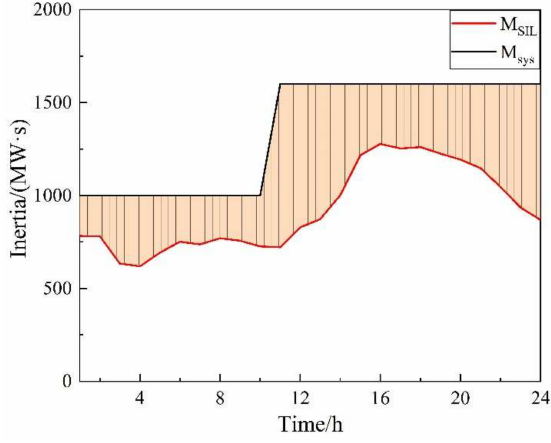
Figure 14. Typical daily inertia security region for scenario 1.